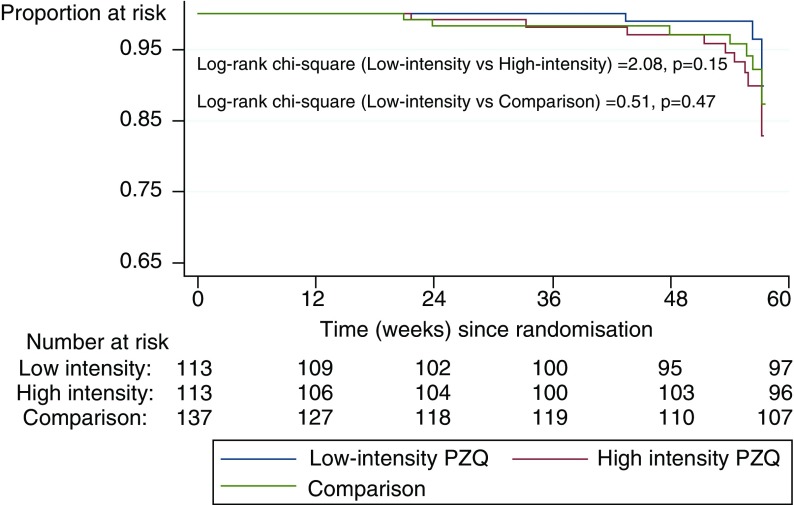
Volunteers moving up in WHO staging by study group.PZQ – praziquantel.